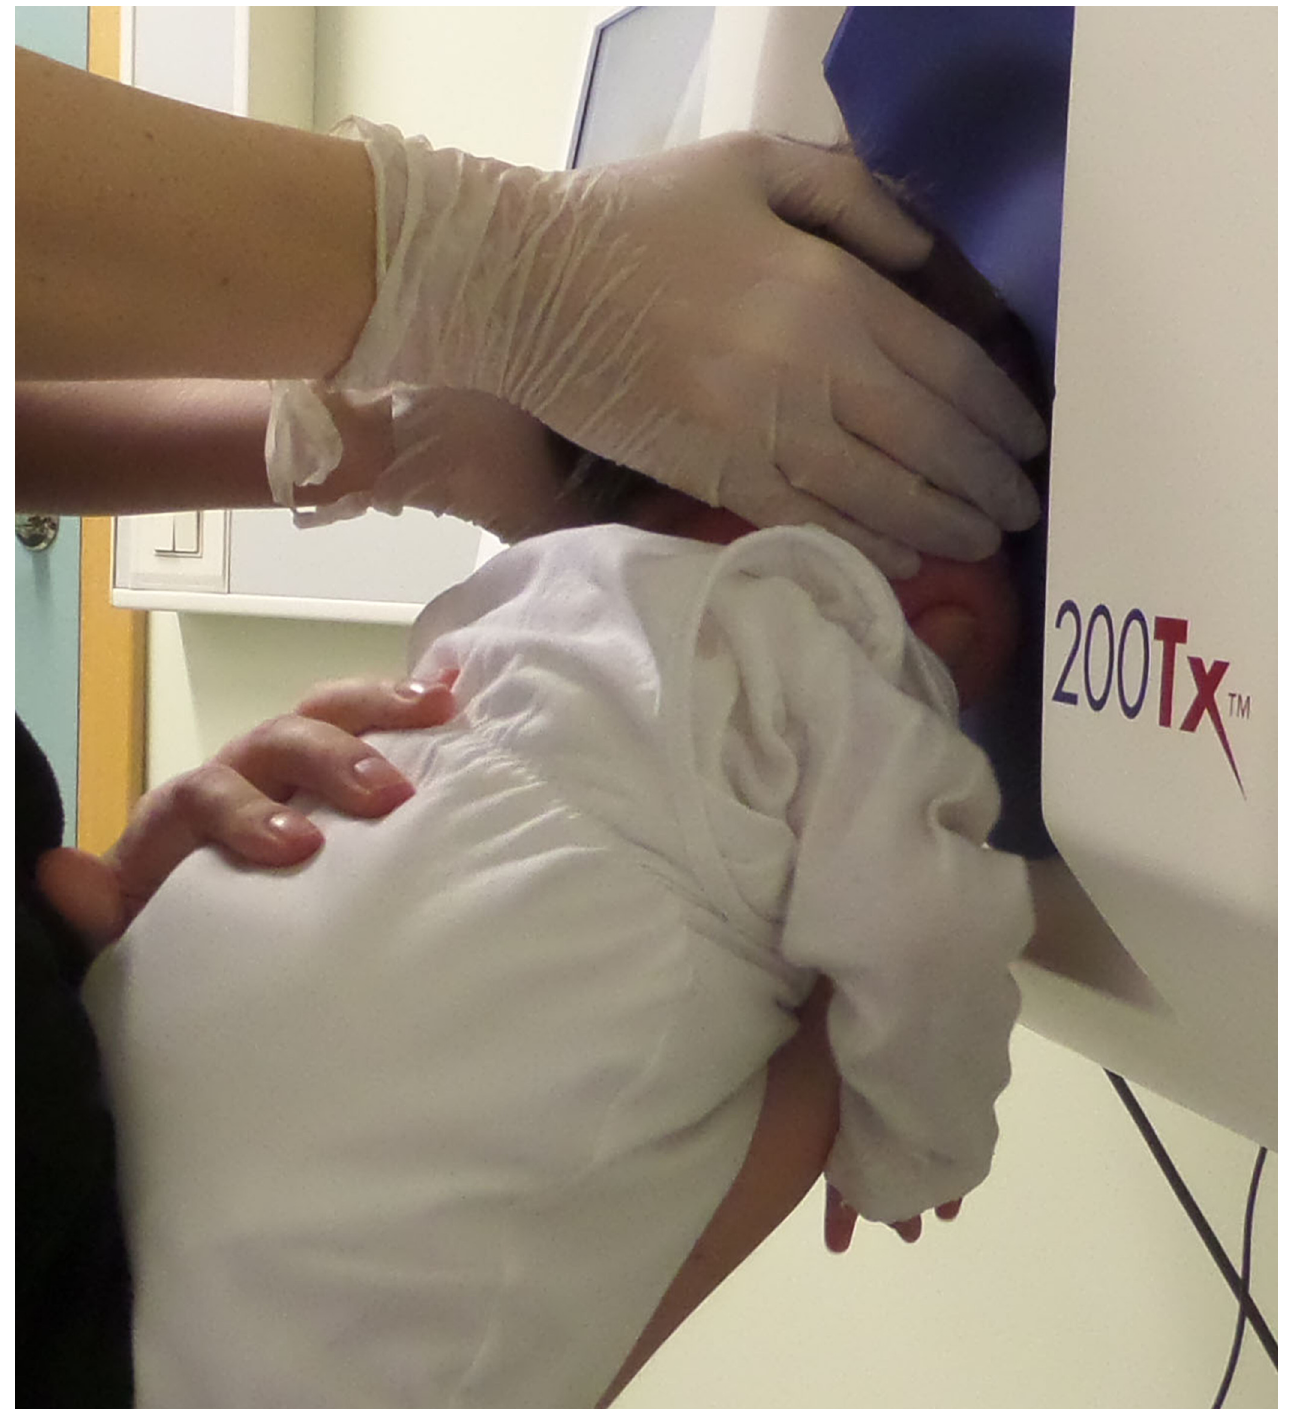
Fig 1. Modified-flying baby position for alignment with the Scanning Laser Ophthalmoscope.